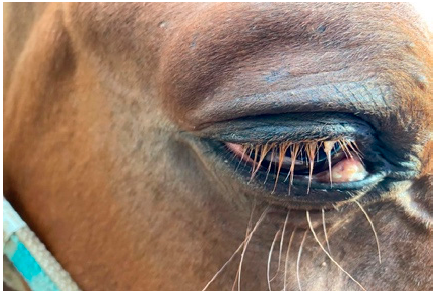
Figure 1. Mass on the right eye, of approximately 2 cm, located on the lower eyelid conjunctiva close to the medial canthus.